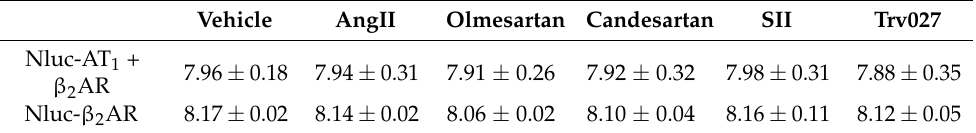
Figure 7. Competition binding of BODIPY-propranolol to β 2 AR and the AT 1 - β 2 AR heteromer. Cells expressing Nluc-AT 1 + β 2 AR ( a ) or Nluc- β 2 AR ( b ) were treated with 50 nM BODIPY-propranolol in the presence of various AT 1 ligands (1 µ M) and increasing concentrations of propranolol. Data are normalized to vehicle treatment for that transfection (0% being 10 µ M propranolol-treated and 100% being vehicle only treated) and displayed as relative BRET ratio, mean ± SEM of four independent experiments. Table 1. pIC 50 values from competition curves in Figure 7. No significant differences were observed within each transfection using one-way